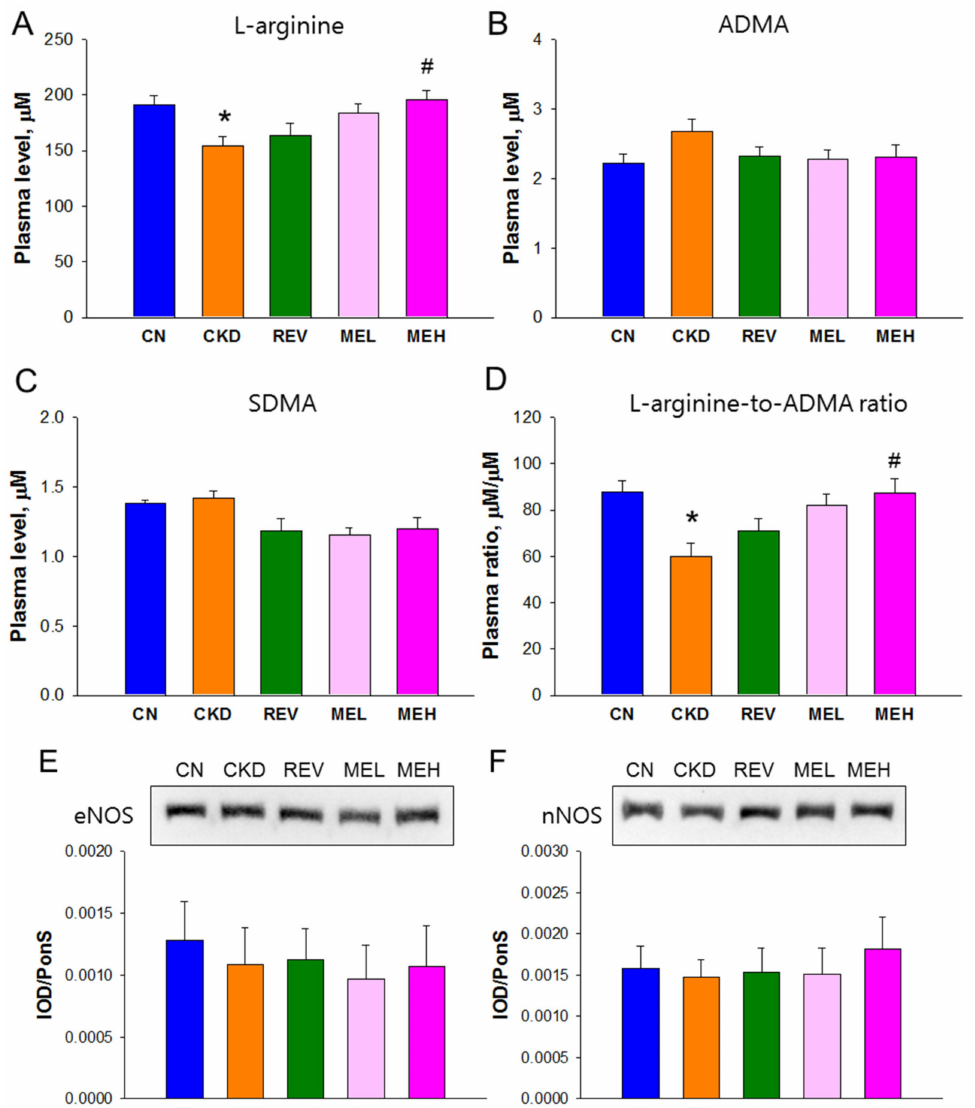
Figure 2. NO parameters and nitric oxide synthase (NOS) expression in rats at 12 weeks of age. Plasma concentrations ( A ) L-arginine, ( B ) asymmetric dimethylarginine (ADMA), ( C ) symmetric dimethylarginine (SDMA), and ( D ) the L-arginine-to-ADMA ratio. Protein expression of ( E ) endothe- lial NOS (eNOS, 140 kDa) and ( F ) neuronal NOS (nNOS, 155 kDa) in rat kidneys. n = 8/group; * p < 0.05 vs. CN; and # p < 0.05 vs.